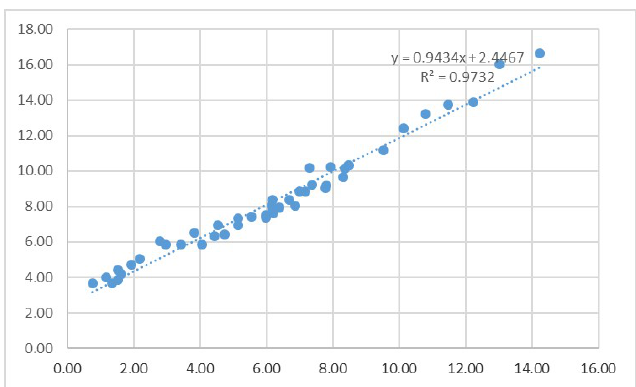
Figure 1. The 5-year treasury constant maturity rate ( X ) vs. the 30-year fixed rate mortgage average ( Y ) in the United States.